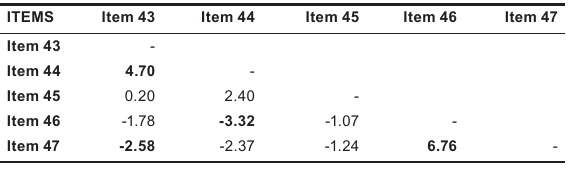
TABLE 11 Standardised residuals for Sales personnel dimension – Mall intercept study